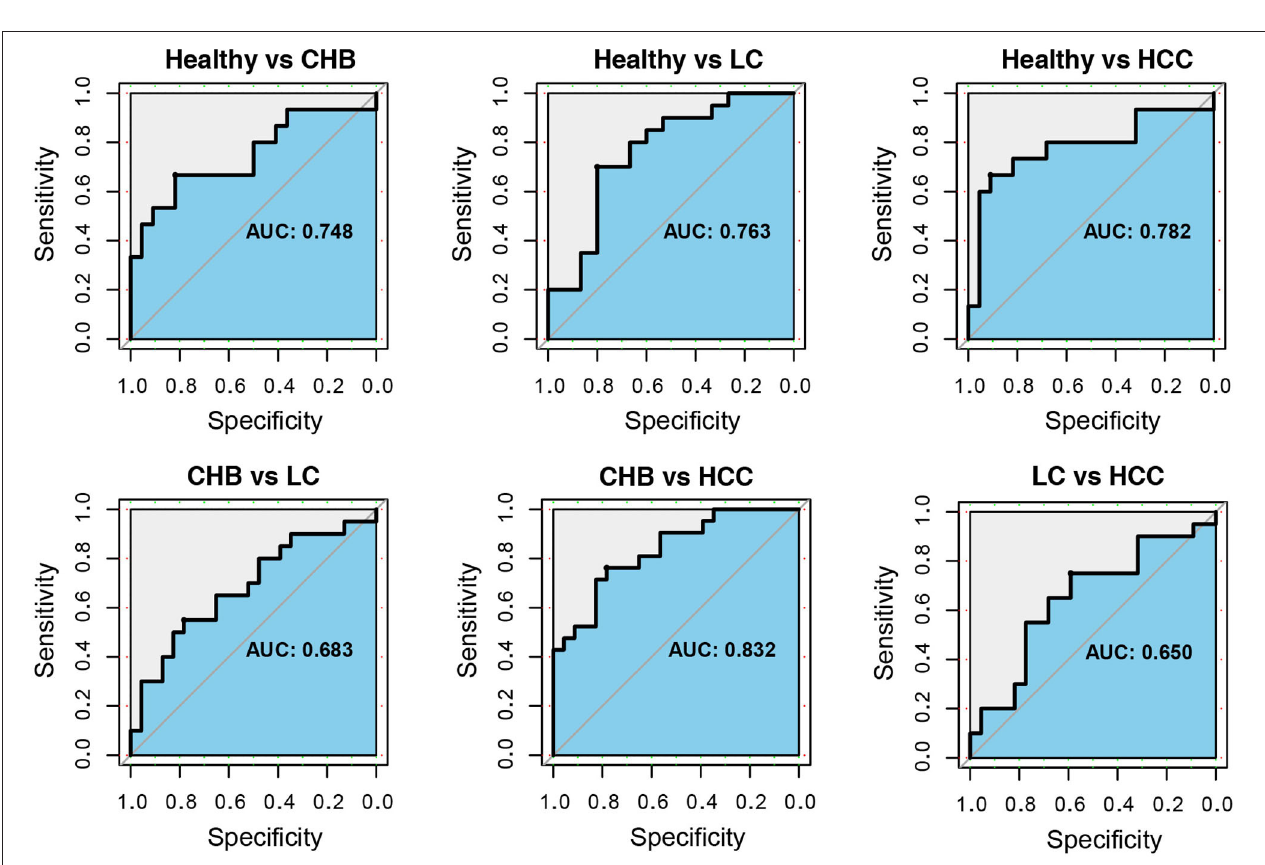
FIGURE 6 | The receiver operating characteristic curves for classifiers based on the 13 signature genera. For each comparison between healthy and CHB, healthy and LC, healthy and HCC, CHB and LC, CHB and HCC, LC and HCC, the ROC curve and area under curve (AUC) were shown. The LASSO binary classifiers were trained by public dataset and validated in the independent